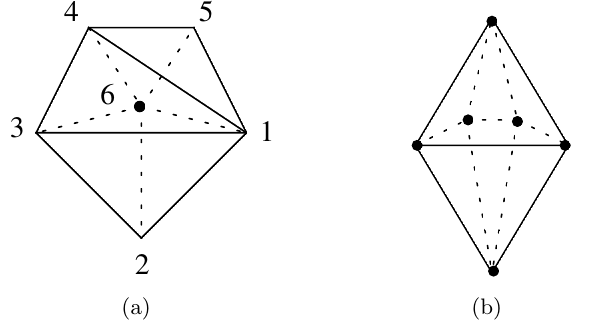
Figure 6 . Two 3 d polytopes with six vertices. (a) Cyclic polytope. (b) Non-cyclic